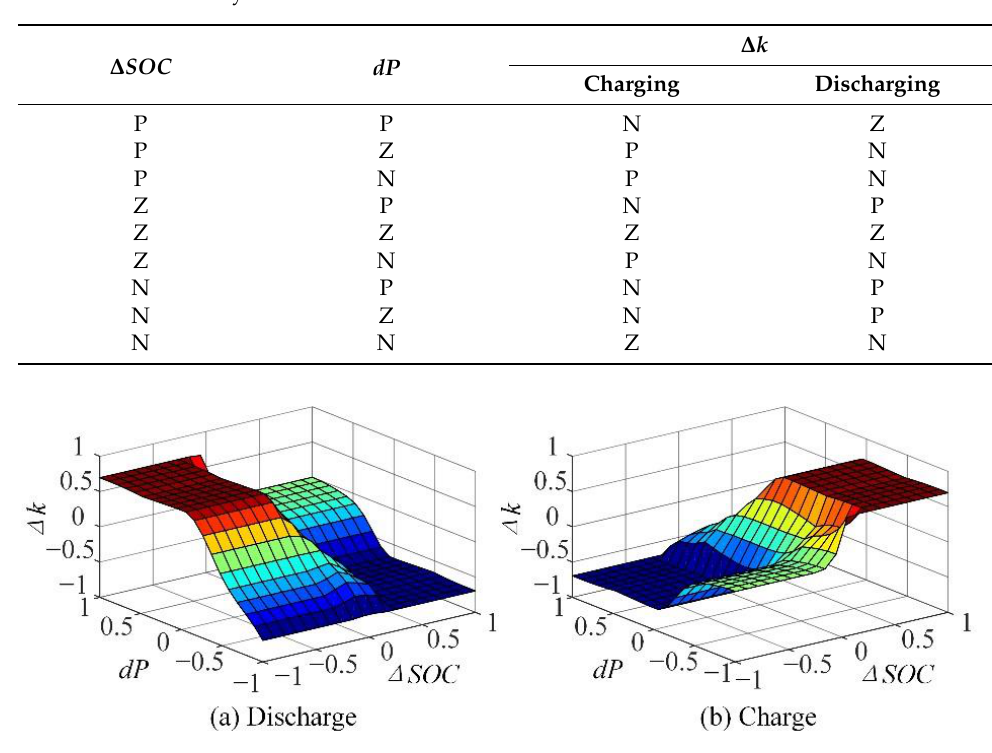
Figure 4. Control surface. ( a ) Discharge; ( b ) Charge.